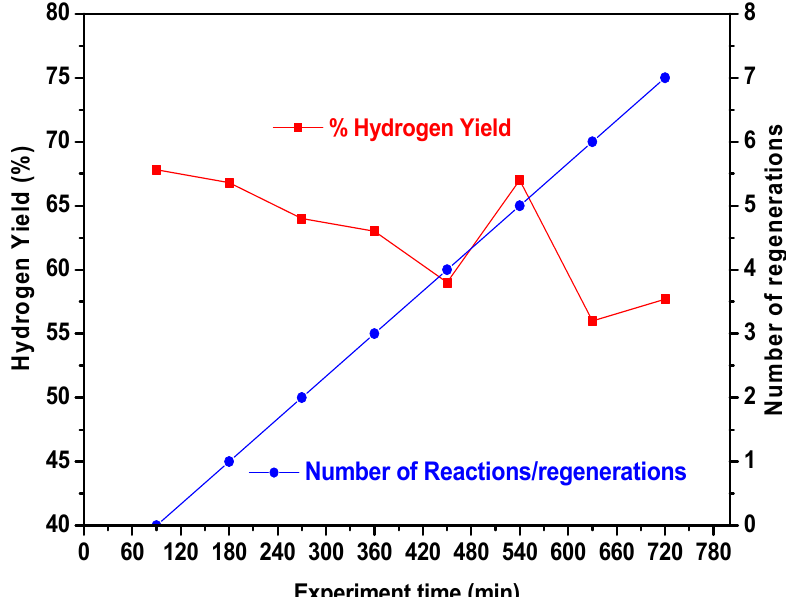
Figure 6. Time on stream (TOS) yield of hydrogen versus different regeneration times with 15%Co–30%Fe/Al 2 O 3 spent-catalyst. TOS conditions: T regeneration-activation = 500 °C; T reaction = 700 °C; (WHSV = 5000 mL/H·g-cat), total flow rate = 25 mL/min and CH 4 /N 2 = 1.5.